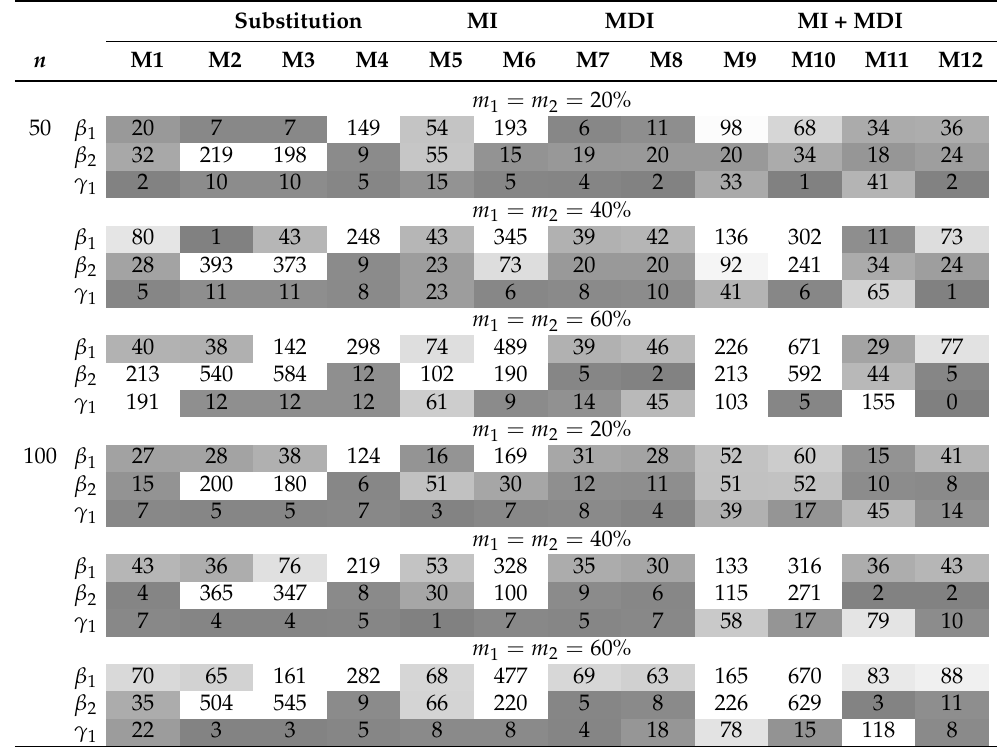
Table 1. Summary of the AAB ( × 1000) when covariates are independent and X ∗ to lower LOD. M1 is complete-case analysis; M2–M4 are the different variants of the substitution methods; M5–M6 are the different variants of the MI methods; M7–M8 are the different variants of the MDI methods; M9–M12 are the different variants of MDI-embedded MI (MI + MDI) methods. AAB less than 0.1 is highlighted in gray, with darker tones corresponding to smaller AAB.